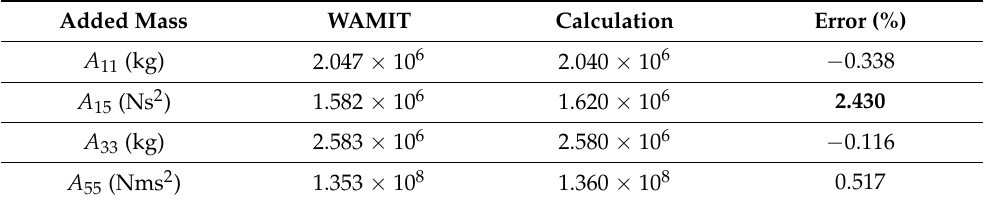
Table 1. A comparison of added mass at infinite